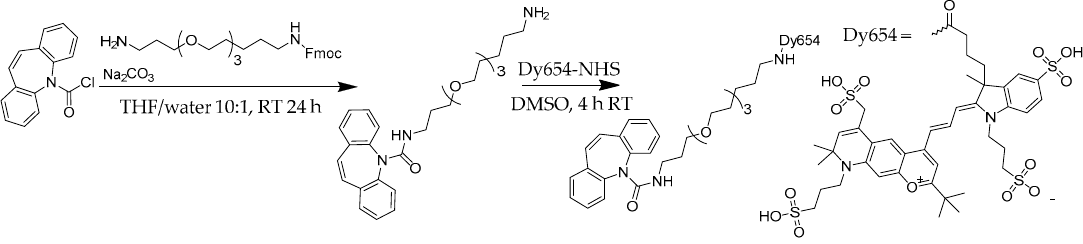
Figure 1. Synthesis of the CBZ-TOTA-Dy654 tracer [26].